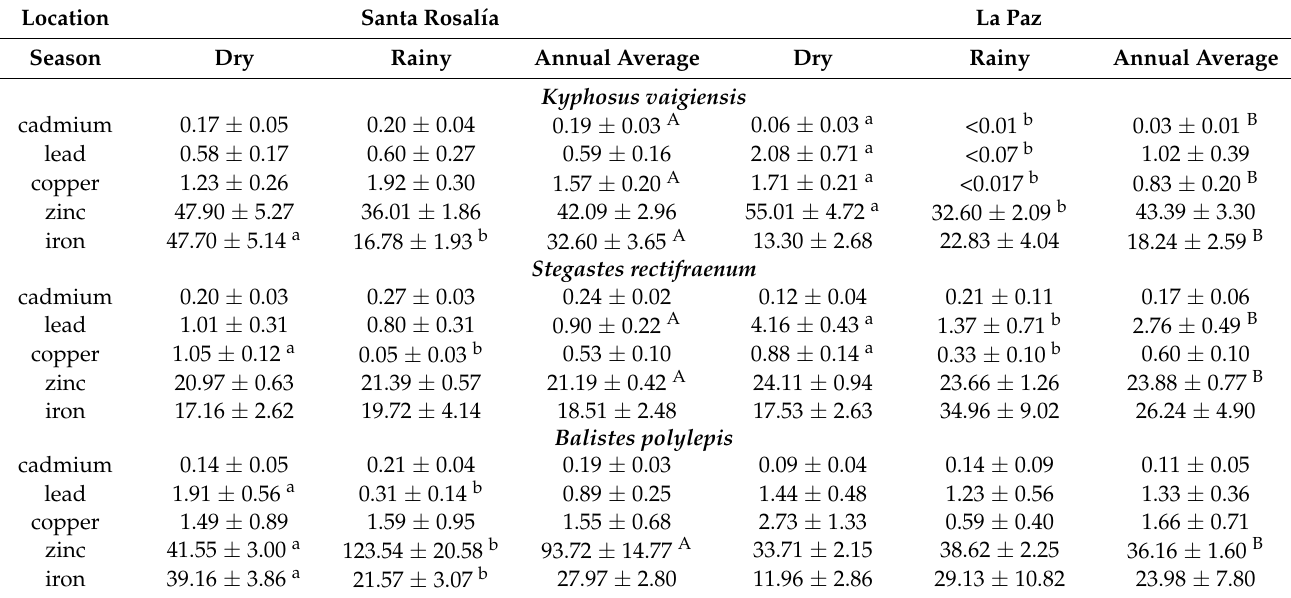
Different letters indicate significant differences ( p < 0.05) in annual average between locations (Santa Rosalia (A) vs. La Paz (B) ) and between seasons within each location—dry (a) vs. Rainy (b)